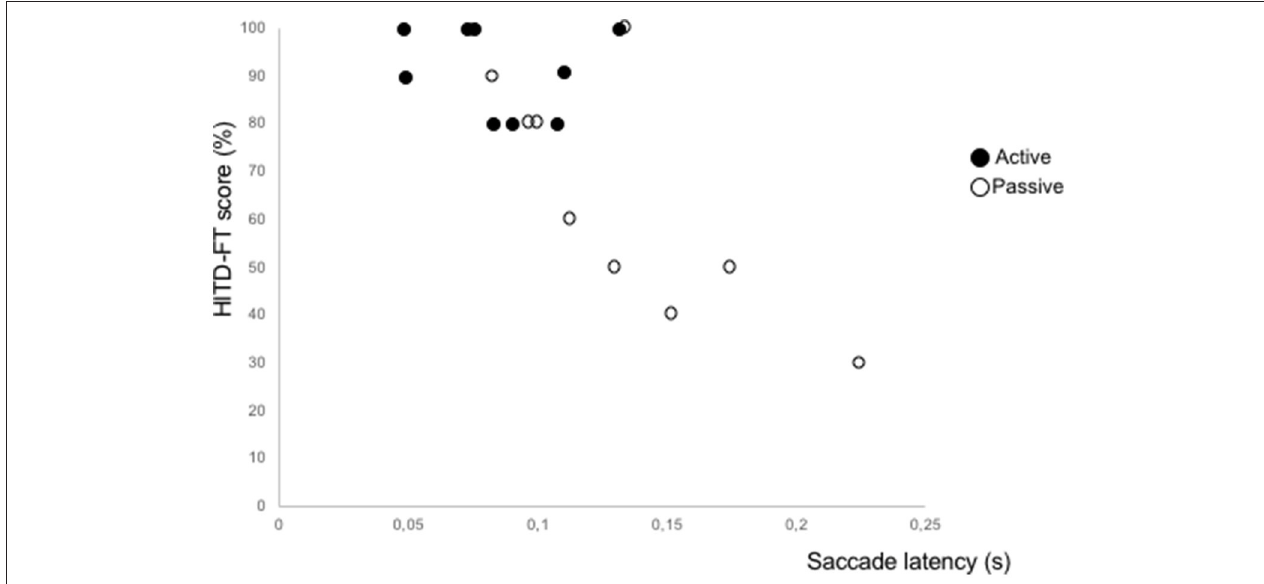
FIGURE 3 | Graphical illustration of HITD-FT scores vs. latencies of corrective saccades, triggered during passive and active ipsilesional head-impulses.